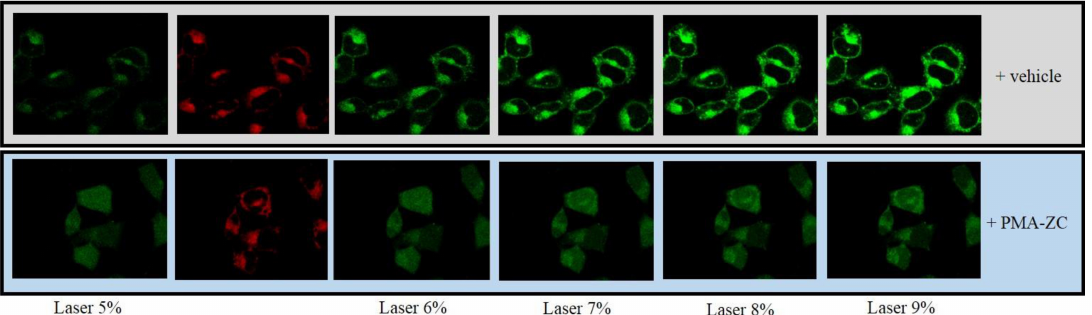
Figure 4. Mitochondrial ROS production in SH-SY5Y neuronal cells. In this particular set of images, a set of cells (lower panels) were preincubated with tribomechanically activated zeolite (TMAZ) and Panaceo Micro Activation (PMA-ZC) (2,5 ng / mL) or vehicle (upper panels) for 30 min before the laser excitation. Cells pretreated with TMAZ / PMA-ZC were more protected from oxidative stress than cells that received only vehicle (adapted from Montinaro et al.,